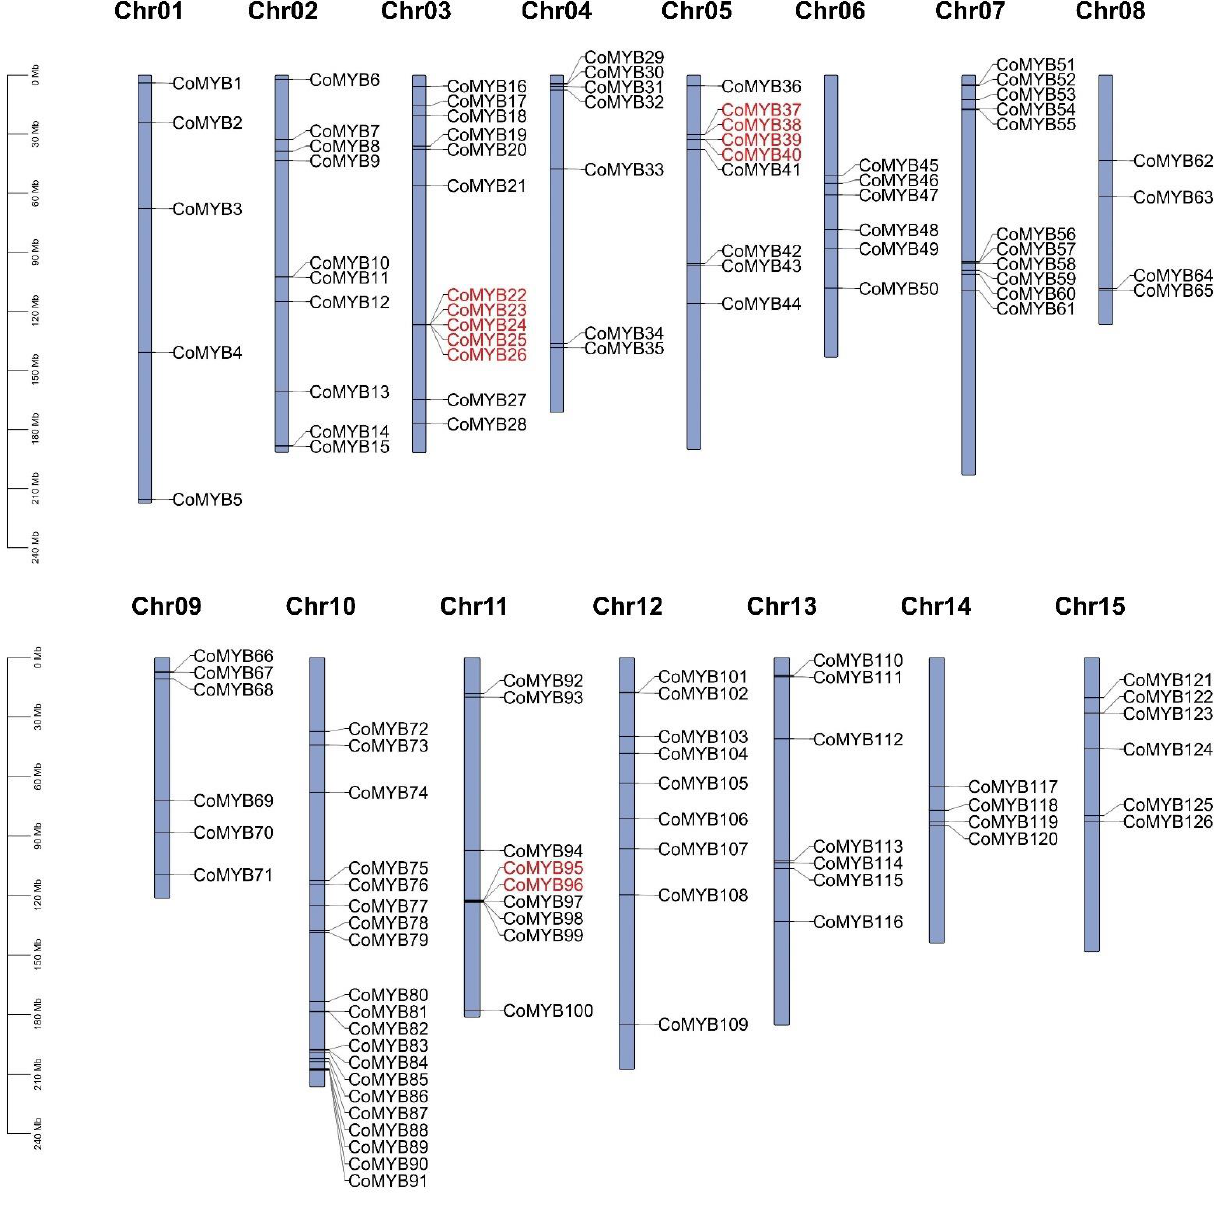
Figure 4. Chromosomal distribution of 128 CoR2R3-MYB genes. Each vertical bar represents one chromosome. The chromosome name is shown at the top of each chromosome. For clarity, we renamed the chromosome name using Chr1-Chr15, based on the original chromosome ID (Table S7). The gene names in red text indicate tandem duplication. The scale on the left is measured in megabase (Mb).